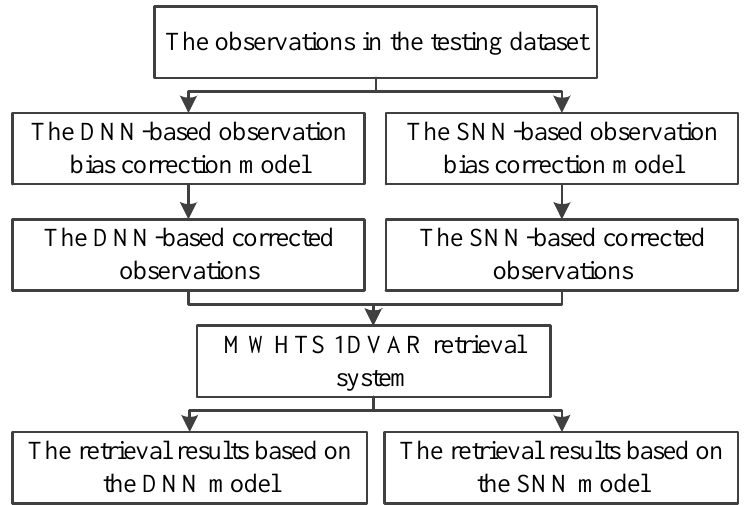
Figure 6. The schematic of the 1DVAR retrieval. The second retrieval scheme: The NN-based retrieval using the observations re- trieved the atmospheric temperature and humidity profiles by the NN-based retrieval